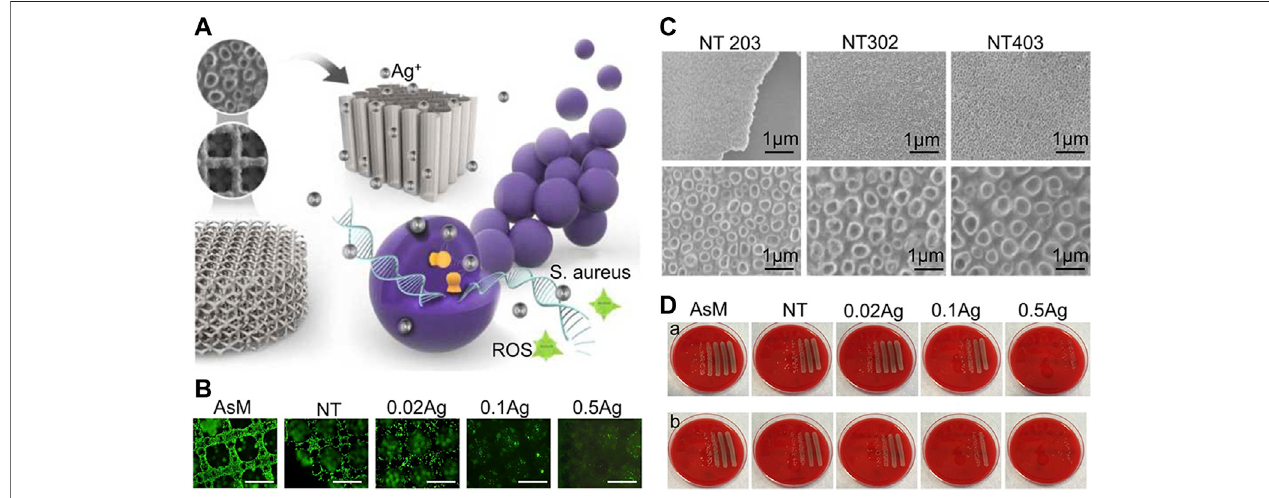
FIGURE 5| Ag + coating ofnanotubes prepared by anodic oxidation (Amin Yavari et al., 2016). (A) Schematic diagram of 3D-printed titanium alloy surface covered with nanotubes and carrying Ag + to inhibit bacterial growth. (B) The inhibitory effect of different concentrations of Ag + loaded on the implant surface on cell proliferation andadhesion. (C) SEMimagesofanodizedporoustitaniumwiththefollowingparameters:20 V,3h;30 V,2h;40 V,3 h. (D) AntibacterialperformanceofAsM,NT,NT- 0.02 Ag + , NT-0.1 Ag + , and NT-0.5 Ag + against Staphylococcus aureus after 7 days. The fi rst row corresponds to planktonic bacteria and the second row to adherent bacteria; the group with higher Ag + concentration had obvious antibacterial ability than the group with lower Ag + concentration.